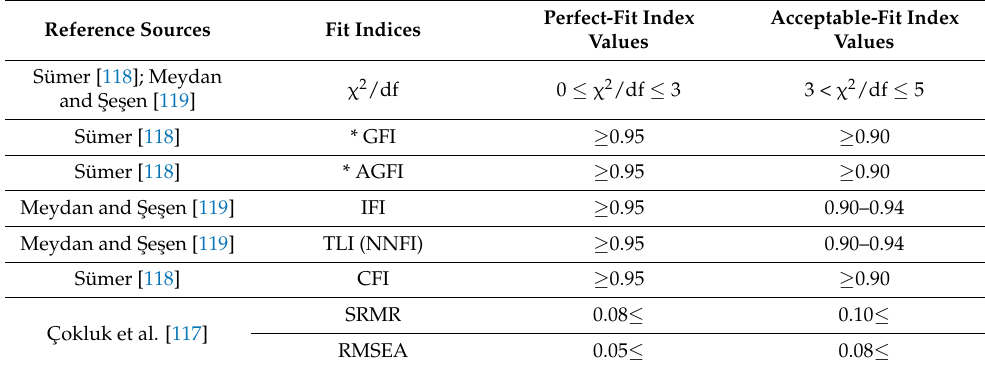
Table 5. Goodness of fit indices used in SEM.